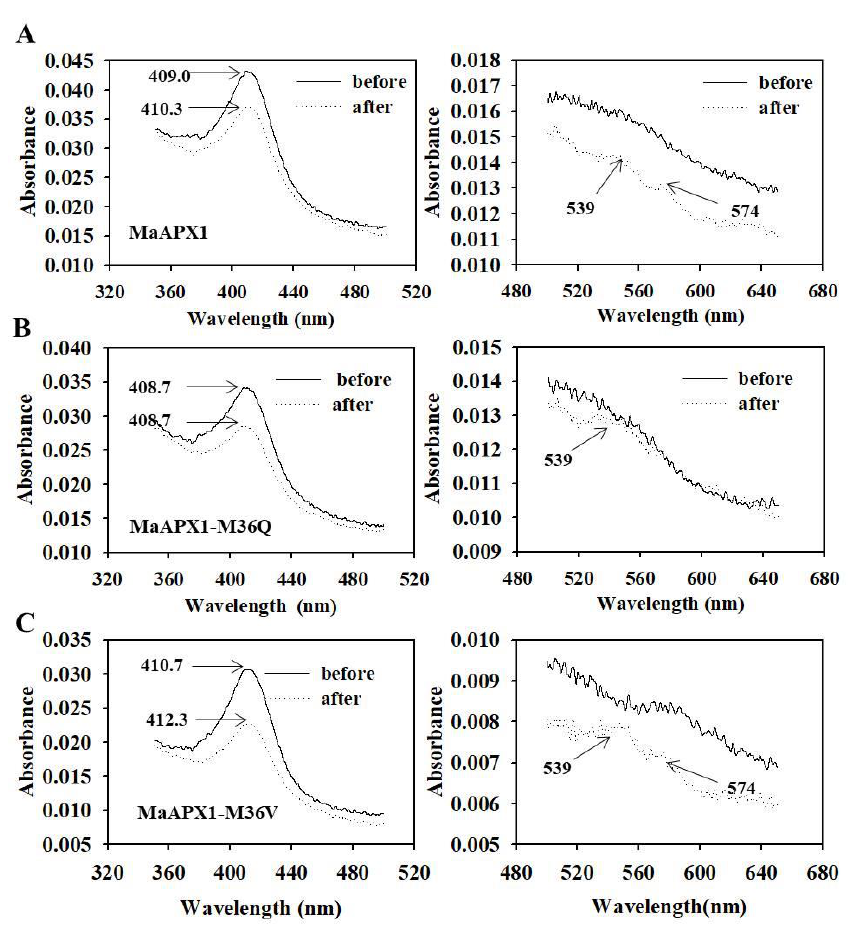
6 Figure 6. Absorption spectra of MaAPX1, MaAPX1-M36Q, and MaAPX1-M36V before and after 650 nm. Arrows indicate the Soret peak of the resting enzyme after the H 2 O 2 reaction. Spectral shifts of the Soret peak are indicative of compound I-like formation. Right, spectra from 500 to 650